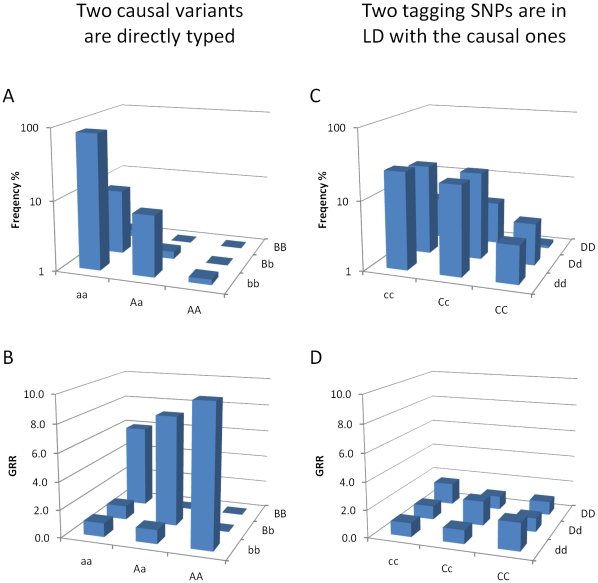
A recessive and compound heterozygote model of the phenotype.At left part of the figure (A and B) two rare recessive variants at the same gene locus are assumed to be directly genotyped. At the right part of the figure (C and D) two non-causal SNPs with higher minor allele frequencies and in LD with the causal SNPs are genotyped. The upper part of the figure depicts the logarithm scaled frequency of the cross genotypes of two variants (A and C). The lower part of the figure is an example of the genetic model under illustrative parameters. GRRAA = 8, GRRAaBb = 7, GRRBB = 6, rac2 = rbd2 = 0.1 (B and D).